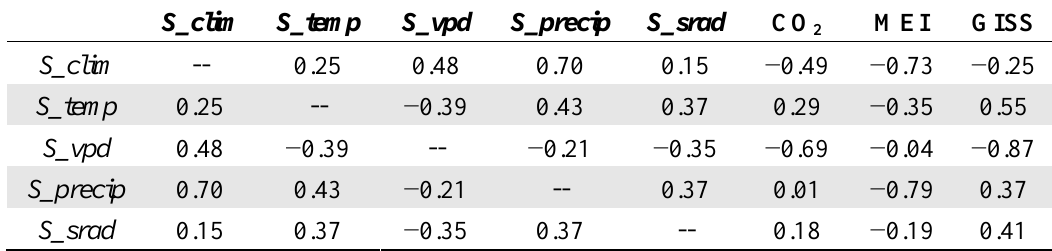
Table 2. Correlation coefficients among five simulated annual GPP ( S_clim , S_temp , S_vpd , S_precip , and S_srad ) with each other, annual CO Multivariate ENSO (El Niño–Southern Oscillation) Index (MEI) [34], and annual mean GISS global land temperature anomaly